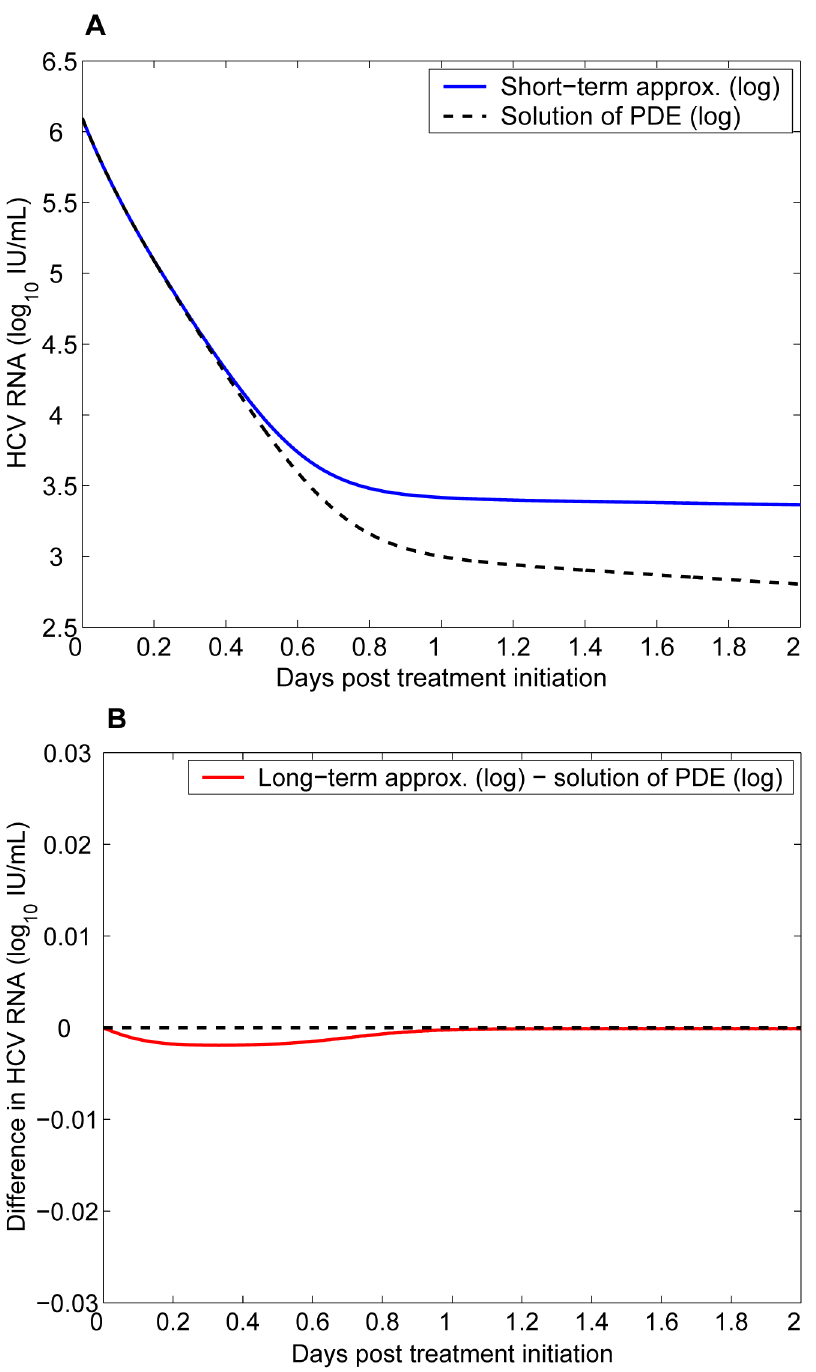
Figure 2. The approximate and the numerical solutions of the multiscale model. A. The short-term approximation (blue solid) is compared with the solution of the multiscale PDE model (black dashed). B. Difference between the long-term approximation and the solution of the multiscale PDE model. Parameter values, chosen from Table 2 and [30], are t 0 ~ 0 , s ~ 1 : 3 | 10 5 cells = mL , d ~ 0 : 01 day { 1 , b ~ 5 | 10 { 8 mL day { 1 virion { 1